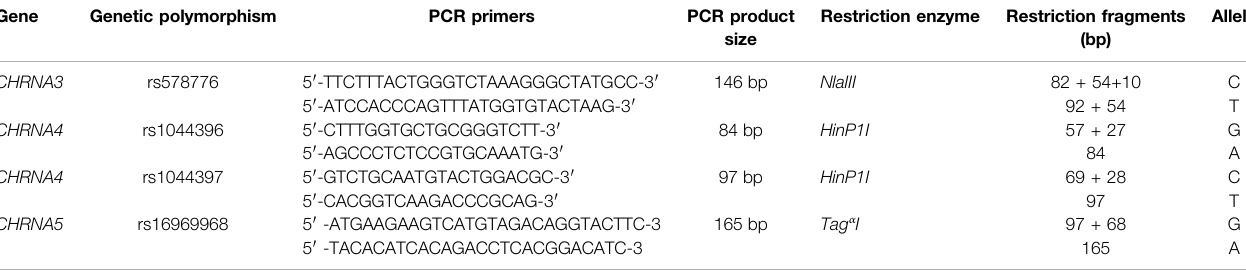
TABLE 1 | Genotyping methods for the CHRNA3 rs578776, CHRNA4 rs1044396- rs1044397 and CHRNA5 rs16969968 polymorphisms.